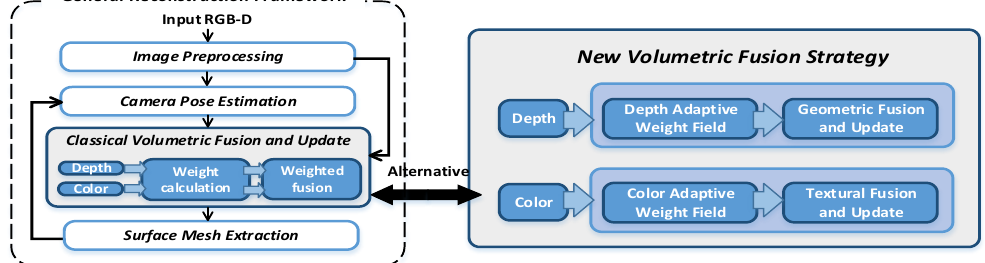
Figure 1. The comparison in the overall framework between the classical voxel fusion method and our approach. On the left side of the figure is a general reconstruction framework using classical fusion methods. On the right of the figure is our new fusion strategy that can be used as a basic module and directly applied to various volumetric construction frameworks.